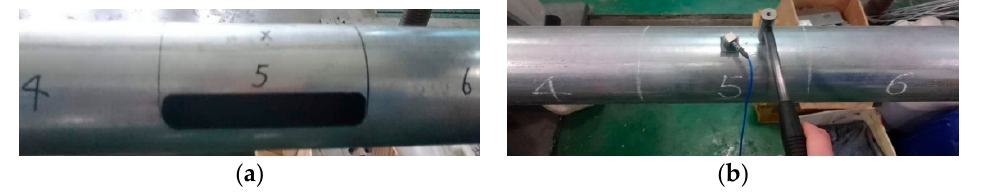
Figure 18. Actual damage and measured response. ( a ) Damage hole; ( b ) Hammer excitation.